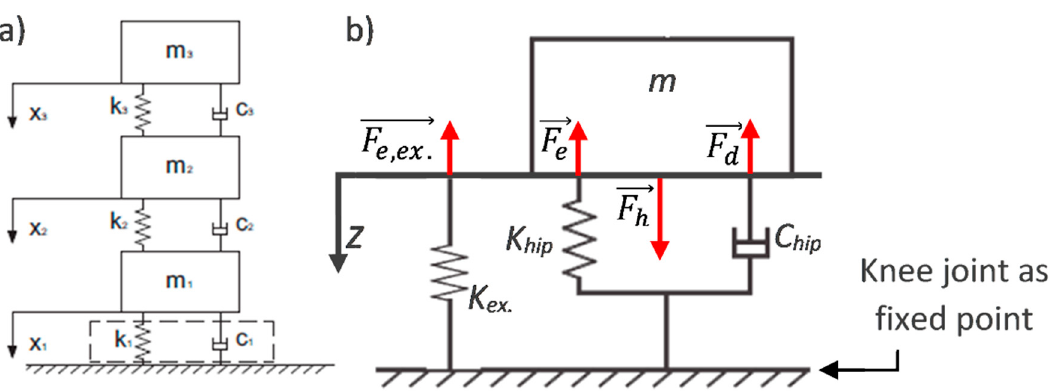
Figure 1. ( a ) Schematic representation of a mass-spring-damper model of the human body [26]; ( b ) Simple MSD model with external complement of the exoskeleton–the forces and constants are described above.